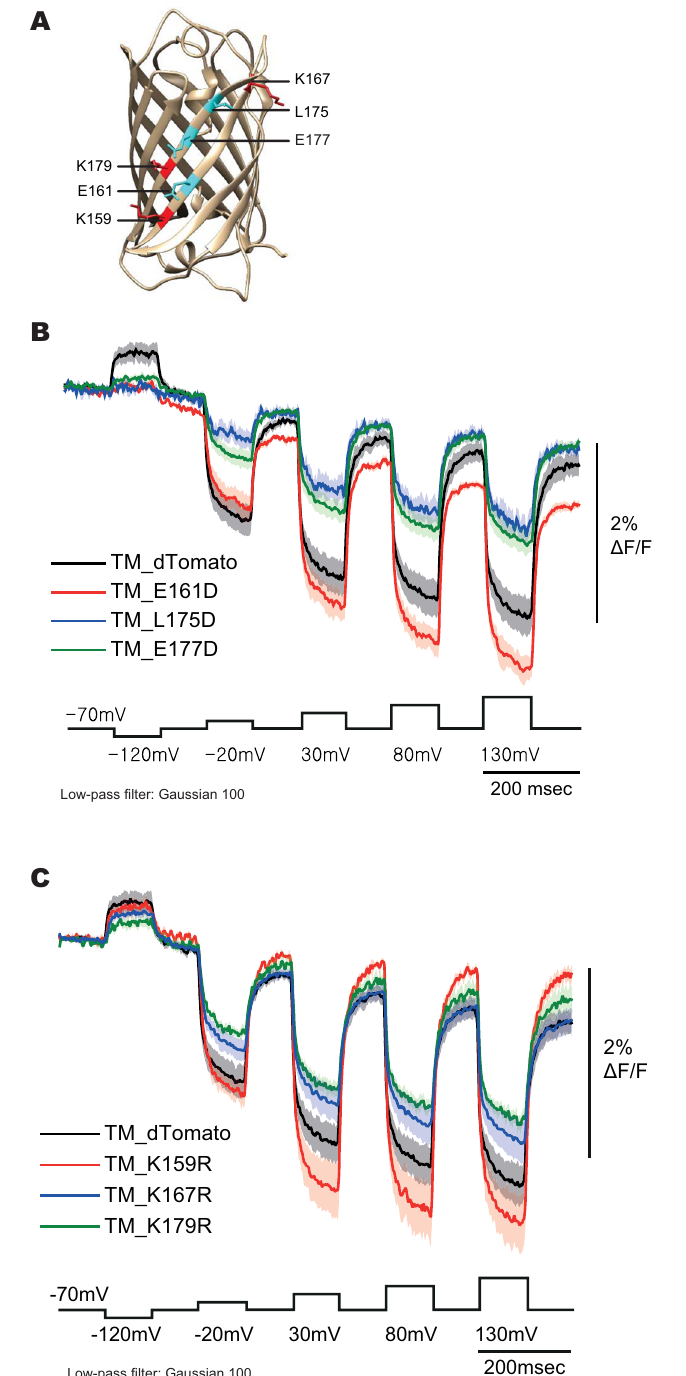
Figure 3. Aspartic acid and arginine scanning mutagenesis of dTomato. ( A ) Crystal structure of dsRed 28 . ( B ) Optical traces of HEK cells expressing the aspartic acid scan mutants. Command voltage pulses are in black. ( C ) Optical traces of HEK cells expressing the arginine scan mutants. Command voltage pulses are in black (n ≥ 4 for all